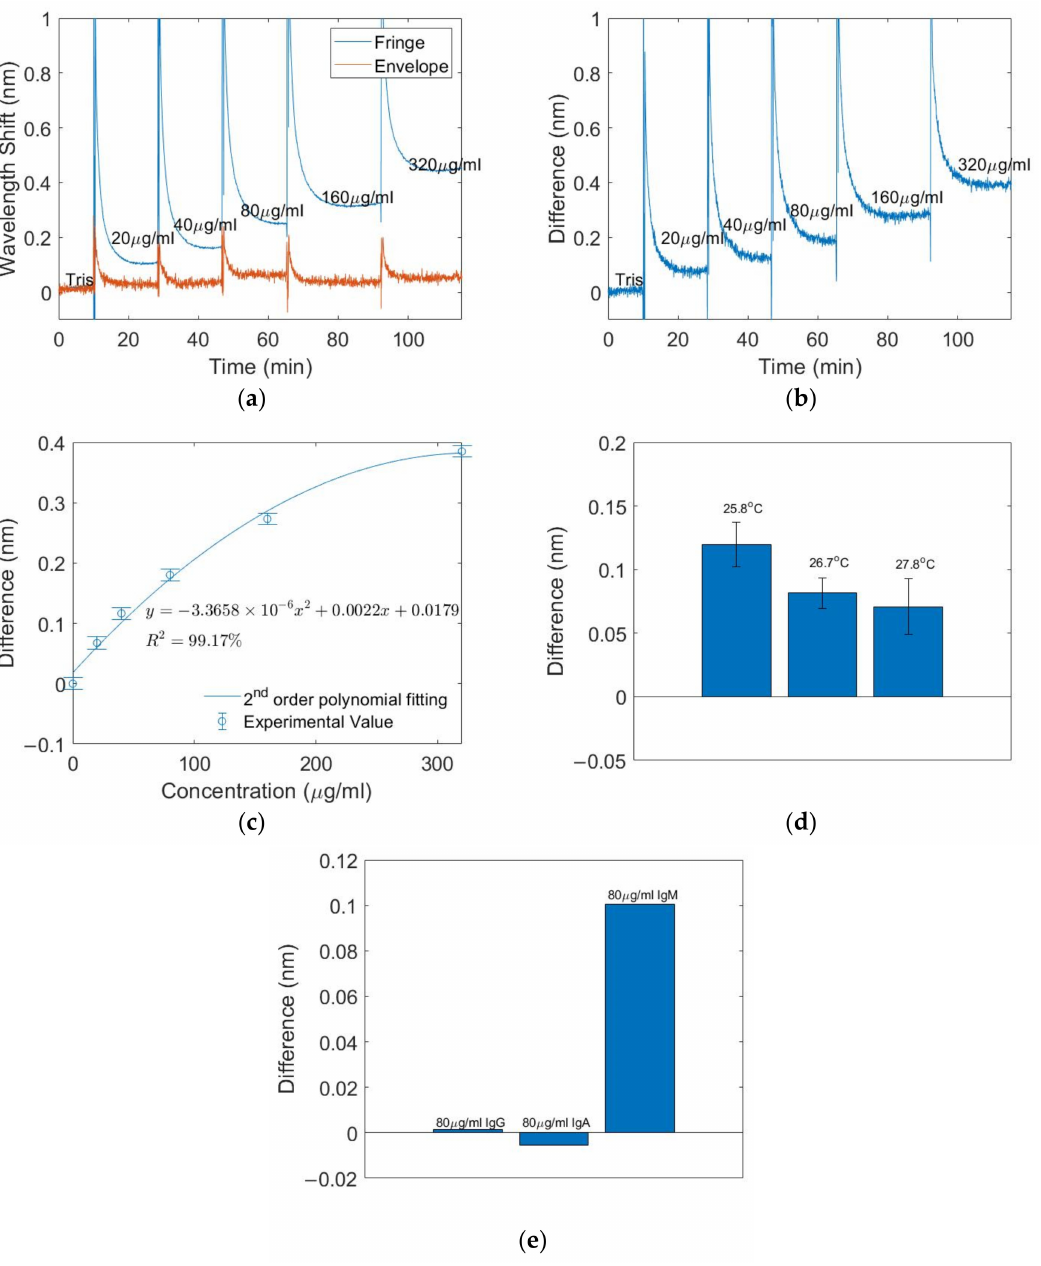
Figure 8. IgM measurements results: ( a ) Wavelength shift of fringe and envelope. ( b ) Difference between the wavelength shifts of fringes and envelope. ( c ) Calibration curve of difference versus con- centration. ( d ) Response to 80 µ g/mL IgM solution under different temperatures. ( e ) Selectivity test. After visual inspection of the data, a second-order polynomial fitting was applied to obtain the calibration curve (Figure 8c), with a coefficient of determination of 99.17%. To investigate the temperature cross-sensitivity, an 80 µ g/mL IgM solution was tested under three different temperatures (Figure 8d). The response reduces slightly with an increasing temperature [18], but this is expected as a higher temperature degrades the intrinsic affinity of antibodies, which leads to a lower binding between the antibody and bioreceptor